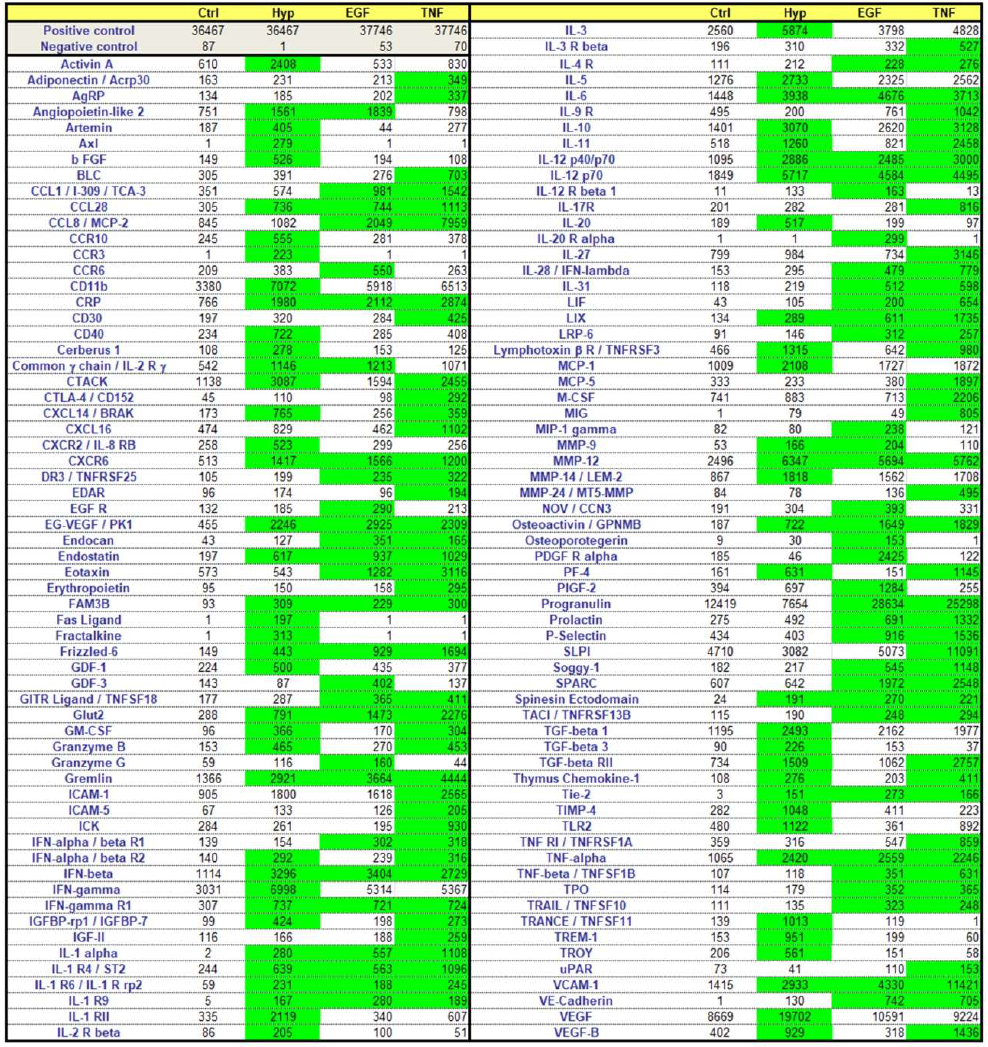
Figure 3. Color map of increased expressed proteins after the preconditioning regimens. Cells were either cultured under standard conditions (Ctrl) or preconditioned by incubation in a hypoxic environment (Hyp; 0.5% O 2 ) or in the presence of murine epidermal growth factor (EGF) (10 ng/mL) or murine tumor necrosis factor α (TNFα) (10 ng/mL) for 48 h. The expression of 308 proteins was measured in the cell supernatant after preconditioning by a commercially available protein array. The heatmap displays proteins enhanced at least >2-fold versus the control and >150 arbitrary units after pretreatment (green).